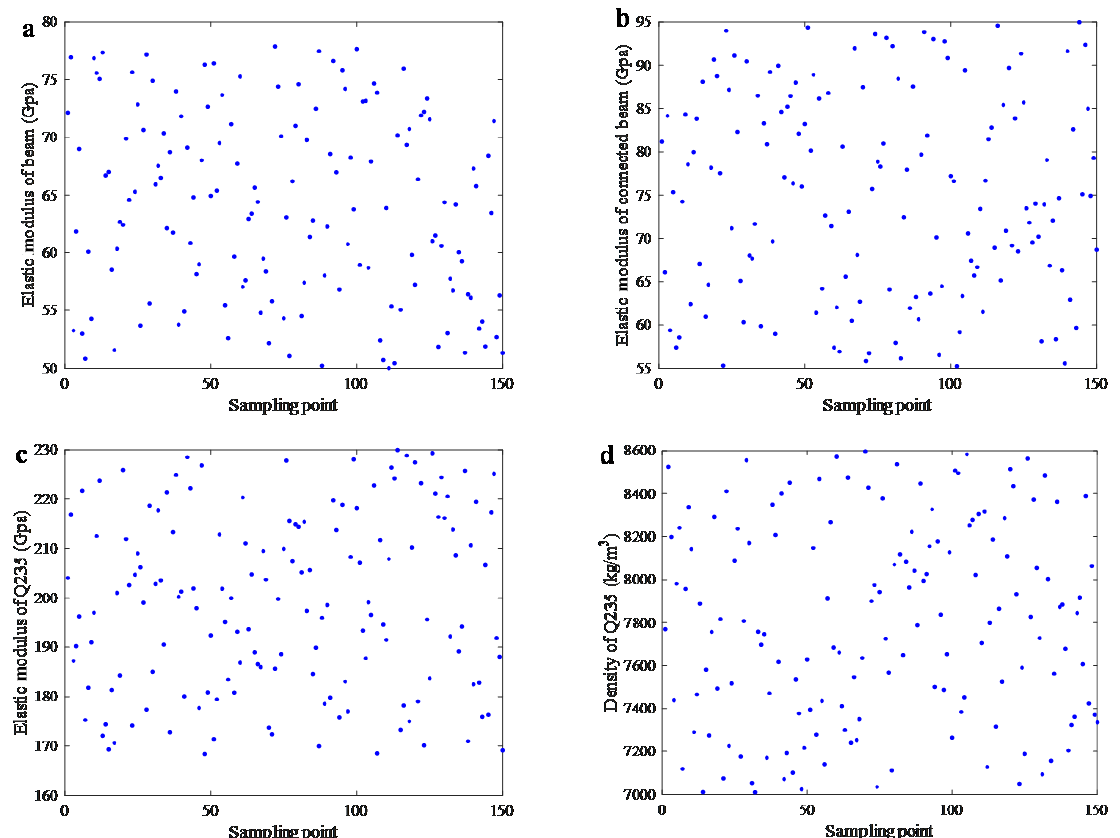
Figure 8. Sample points of parameters that had to be corrected. ( a ) Elastic modulus of beam. ( b ) Elastic modulus of connected beam. ( c ) Elastic modulus of Q235. ( d ) Density of Q235.